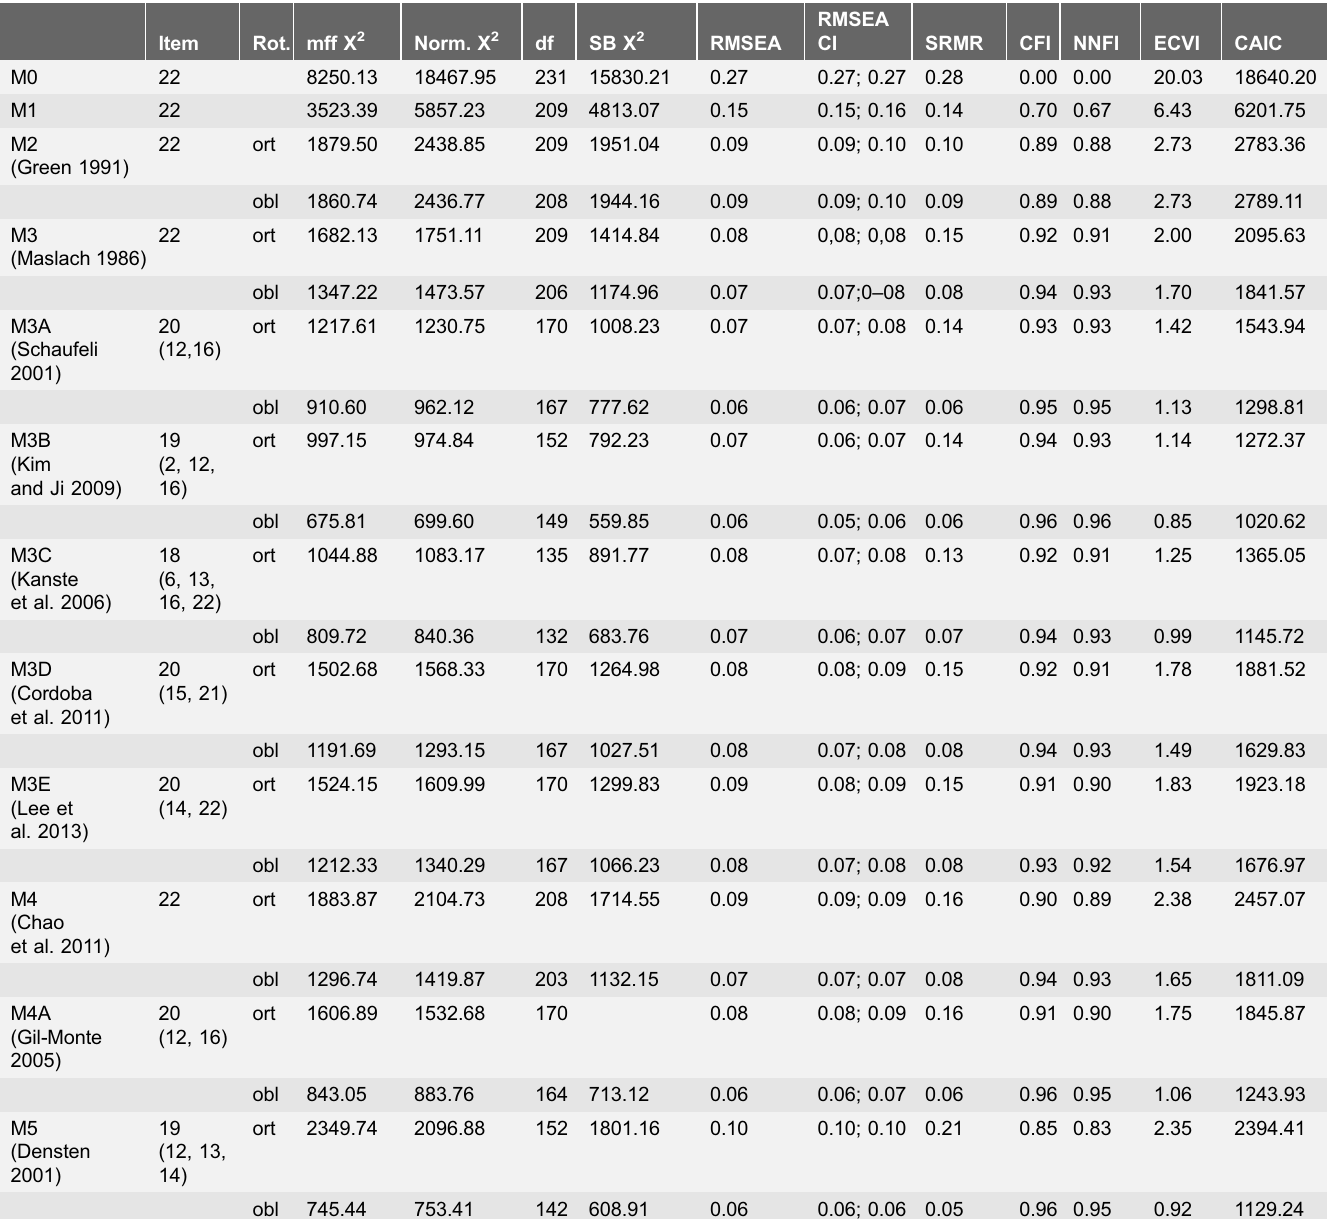
Table 4. Alternative models of MBI_HSS: fit